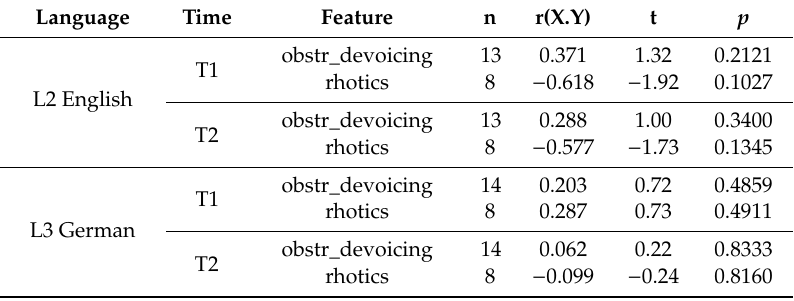
Table 9. Correlation between perception accuracy and RT at T1 and